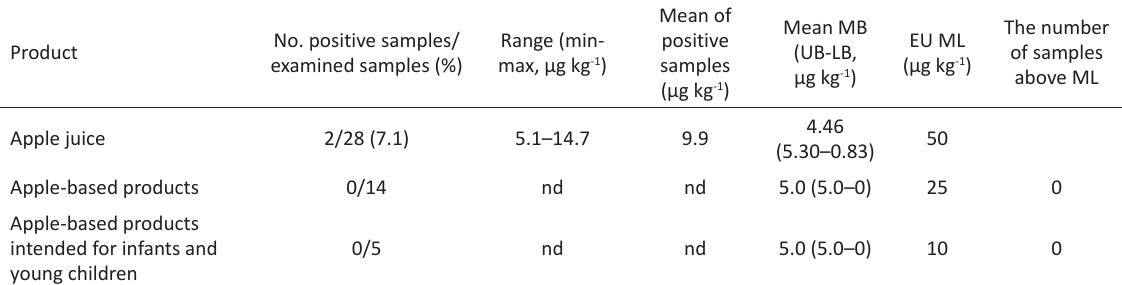
Table 3 . Patulin concentration in examined food samples Product